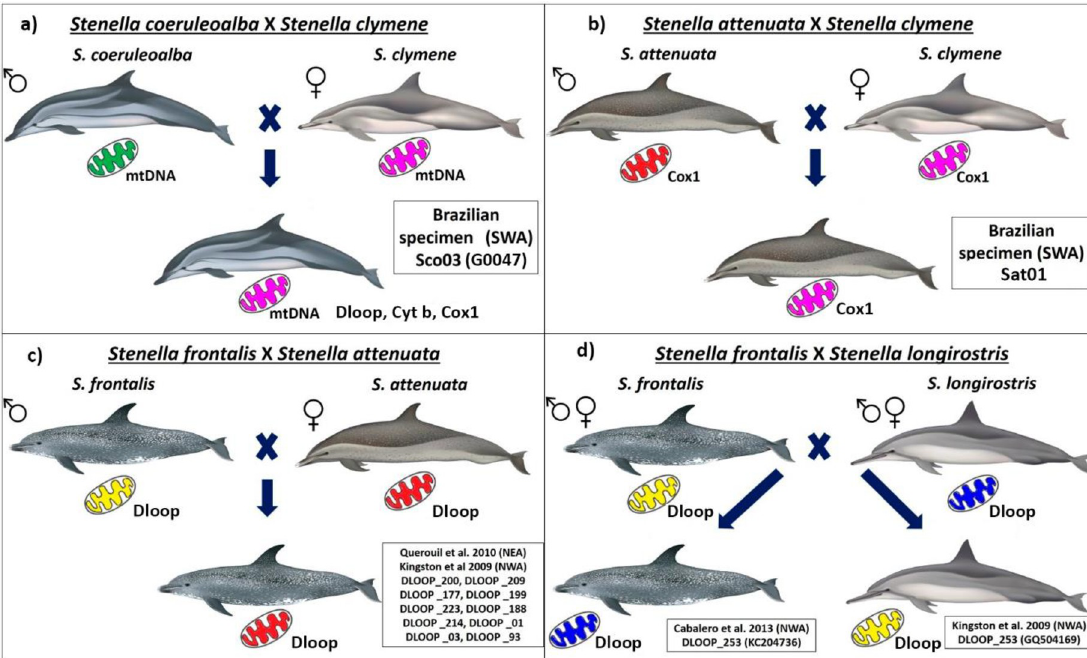
Fig 8. Possible heredograms of admixed individuals among Stenella species: a) between S . coeruleoalba and S . clymene; b) between S . attenuata and S . clymene ; c) between S . frontalis and S . attenuata ; d) between S . frontalis and S . longirostris . The images of the dolphins represent the morphological identity of the specimens, the colour of the mitochondrion represents the mitochondrial identity. In each panel the names of the possible hybrid specimens or the names of the haplotypes representing the possible hybrid specimens are listed. Dolphin images have been extracted from the website http://cis.whoi.edu/science/B/whalesounds/index.cf.